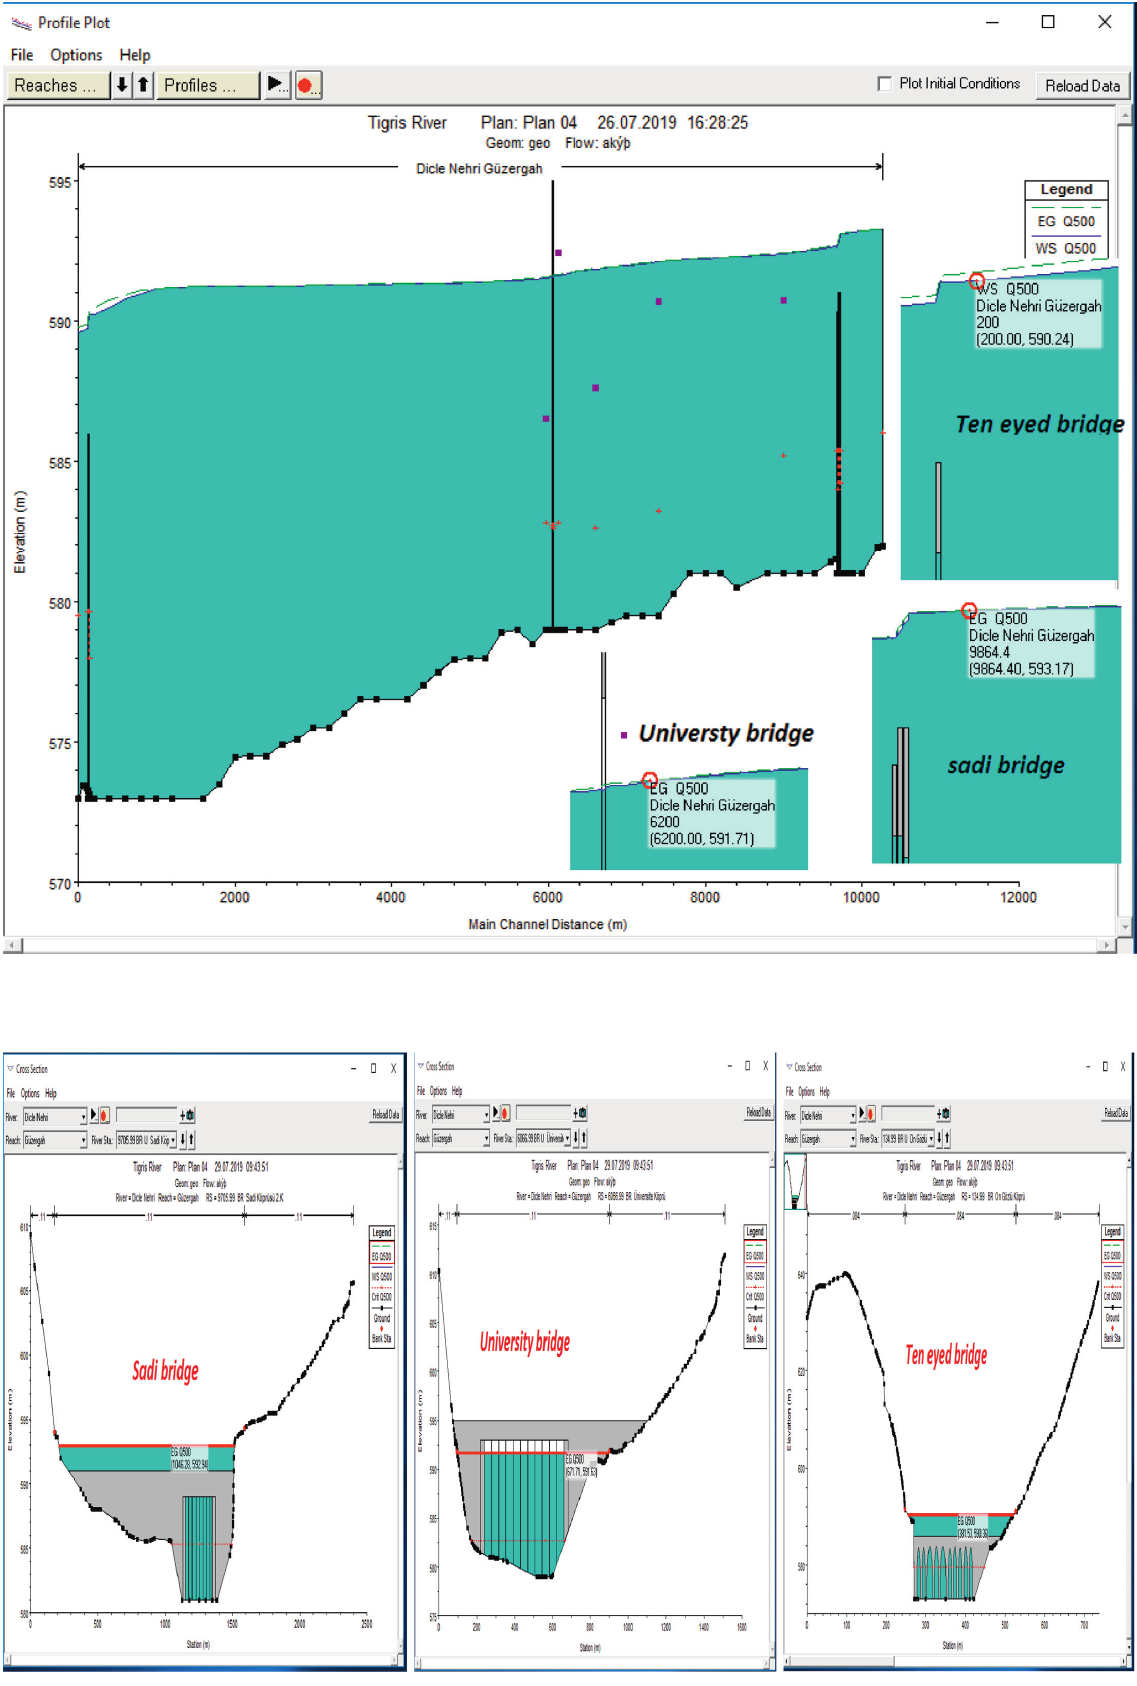
Figure 11: Water surface profiles for bridges (Q